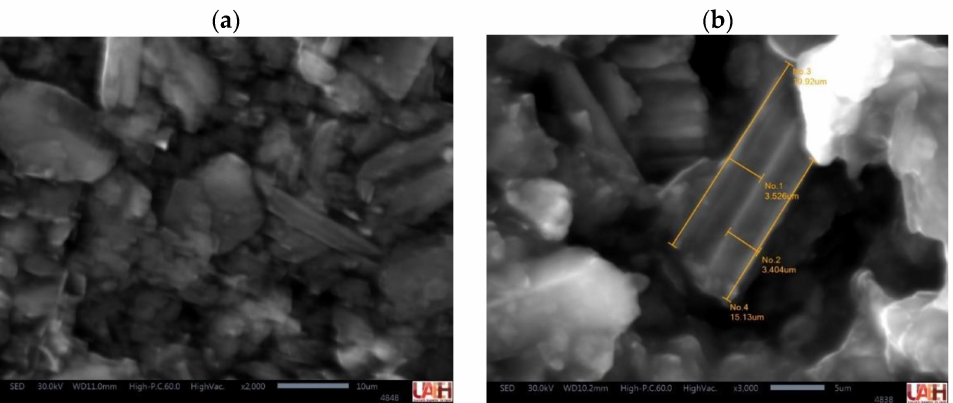
Figure 5. Scanning electron microscopy characterization. ( a ) CPE surface structure. ( b ) MWCNT-CPE surface with carbon structure identification. The images were acquired by applying a primary beam operating voltage of 30 kV, and a magnification ratio of 1:2000 for both